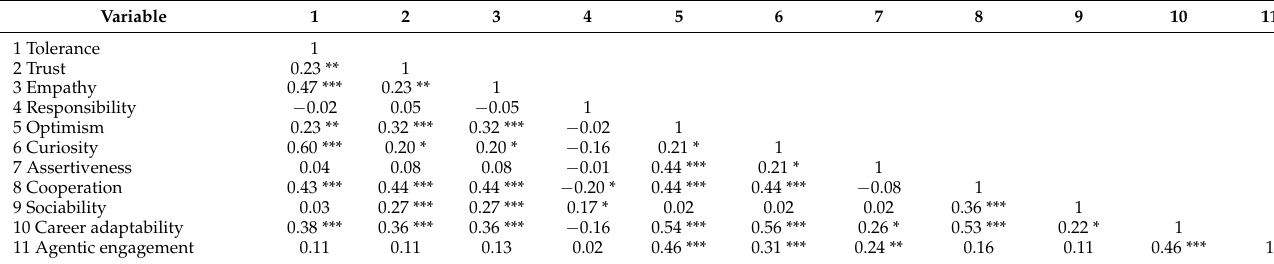
Table 2. Correlation results.